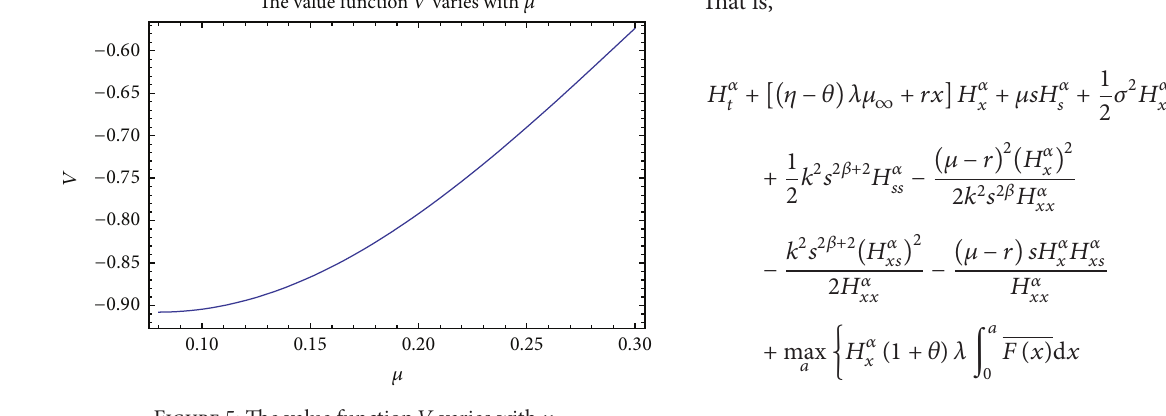
Figure 5: The value function 𝑉 varies with 𝜇